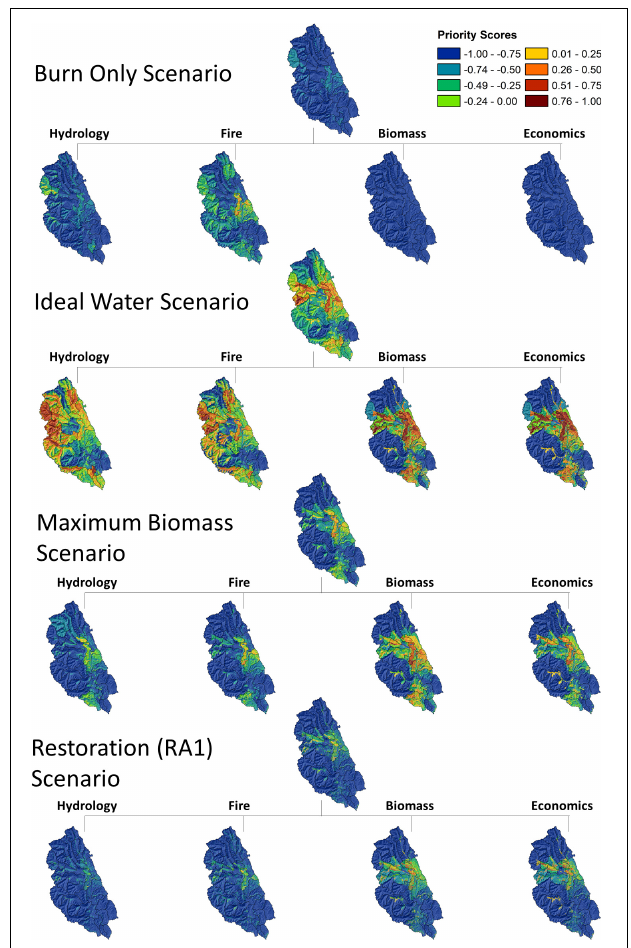
FIGURE 3 | Decision support tool (DST) model results for all four management scenarios. Colors indicate priority values. Warm colors indicate areas with high potential for treatment benefit among each Primary topic area, cool colors indicate lower relative